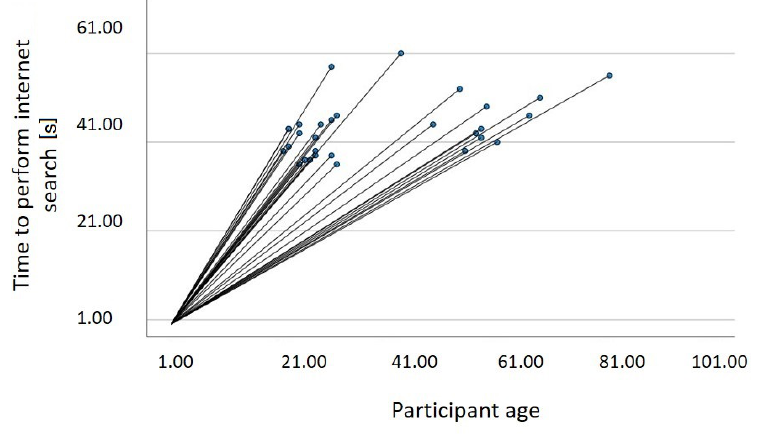
Figure 13. Relationship between age and the time it takes to perform an internet